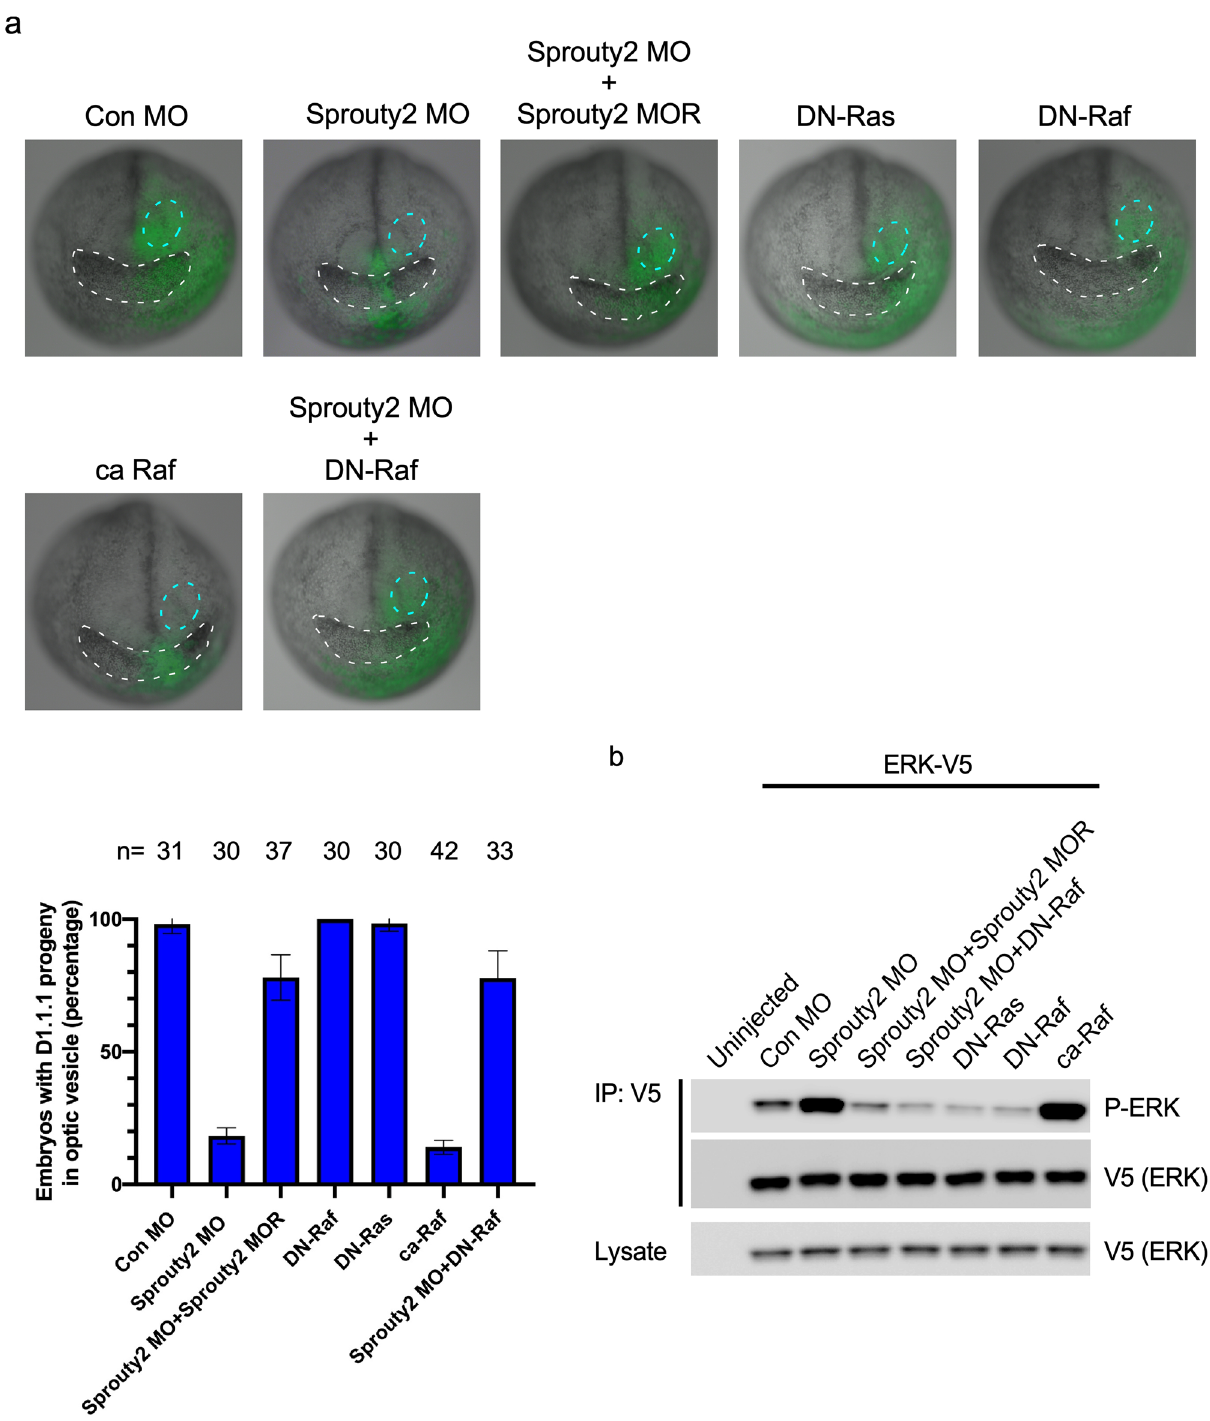
Figure 4. Sprouty2 regulates retinal progenitor movement into optic vesicle through repressing MAPK activity. ( a ) D1.1.1 blastomere was injected with GFP RNA plus RNAs and morpholinos as indicated. Embryos were then harvested and analyzed at late neurula stage. The cement gland was outlined with white dotted line and the optic vesicle was outlined with cyan dotted line. Histograms represent the percentage of embryos with D1.1.1 progeny (GFP positive signals) within the optic vesicle from three biological repeats. Quantification with one- way ANOVA (Sidak’s multiple comparison), P < 0.0001, Error bars indicate ± SD. ( b ) Embryos were injected with indicated RNAs or morpholinos along with ERK-V5 mRNA into D1.1.1 blastomere at 32 cell stage and lysed at neurula stage for immunoprecipitation with V5 agarose beads. Precipitates were then immunoblotted with phospho-ERK and total ERK antibodies. Three independent repeats were